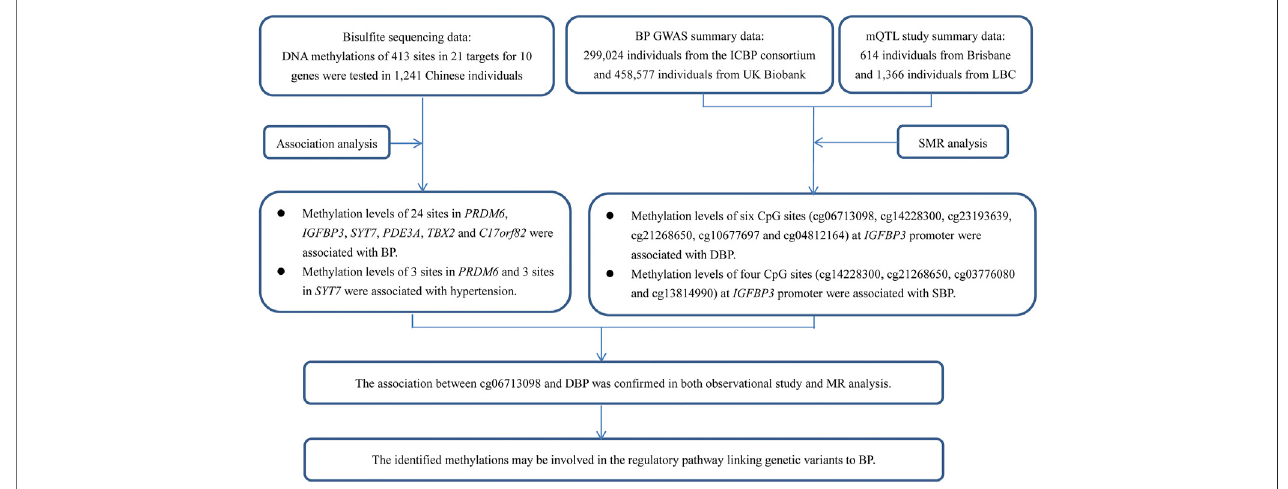
FIGURE1| A fl owchartshowedthedesignofthepresentstudy.Thisstudycontainedtwopartsofanalyses,whichaimedto fi ndevidencetoshowtheassociations between DNA methylations and BP in genetic loci identi fi ed by GWAS. The fi rst part was an observational study examining the associations between DNA methylations at413sitesin21targetsfor10genesandBPin1,241Chineseindividuals.ThesecondpartwasanMRanalysisusingGWASsummarydatafromEuropeans.Theusage of summary data from Europeans can provide supporting evidence for the associations between the methylations and BP, because the causal associations between DNA methylations and BP may not be population speci fi c, even though the data (i.e., genetic associations) used to fi nd the evidence was population speci fi c. Although little evidence was found in the MR analysis, some associations were validated, for example, site cg06713098 was associated with DBP in MR analysis. This site was tested and analyzed in the observational study (IGFBP3_2_113), and was signi fi cantly associated with DBP. Thus, the association between cg06713098 and DBP was con fi rmed in both observational study and MR